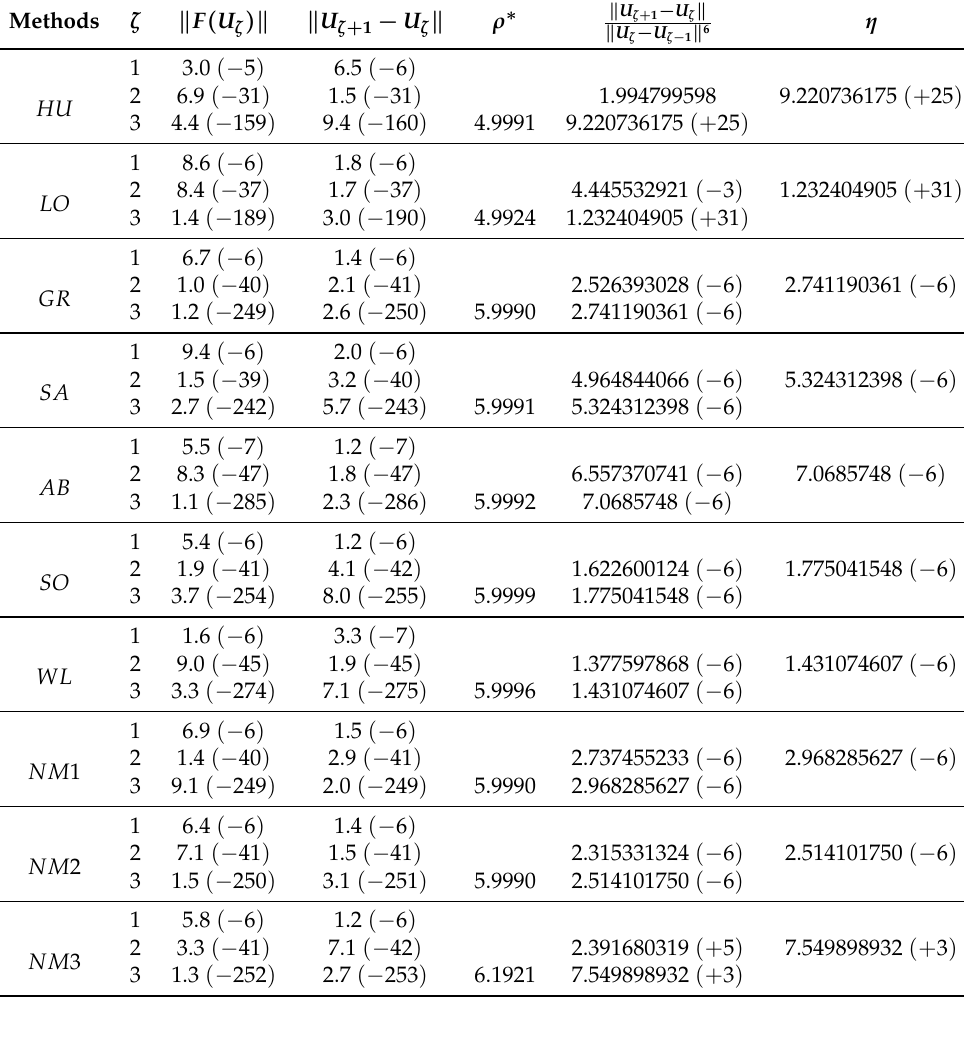
Table 6. Conduct of different techniques in Hammerstein integral problem